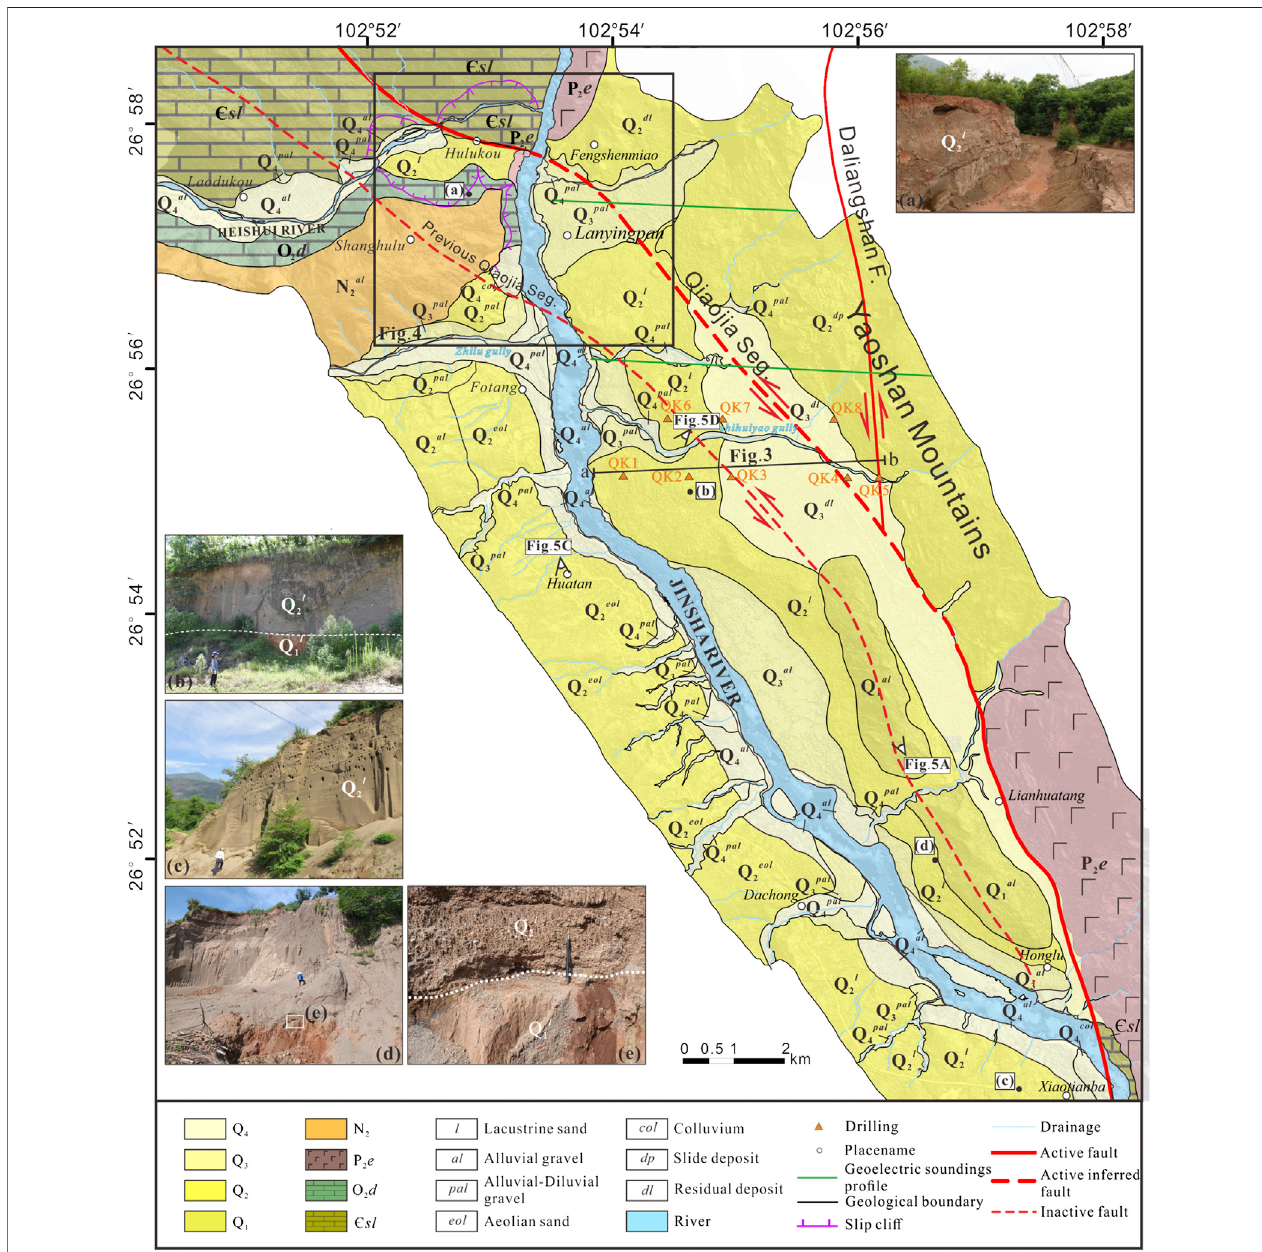
FIGURE 2 | Stratigraphic units of the Qiaojia Basin; the insert photos show two sets of lacustrine sediments with ages of Q 2 and Q 1 .